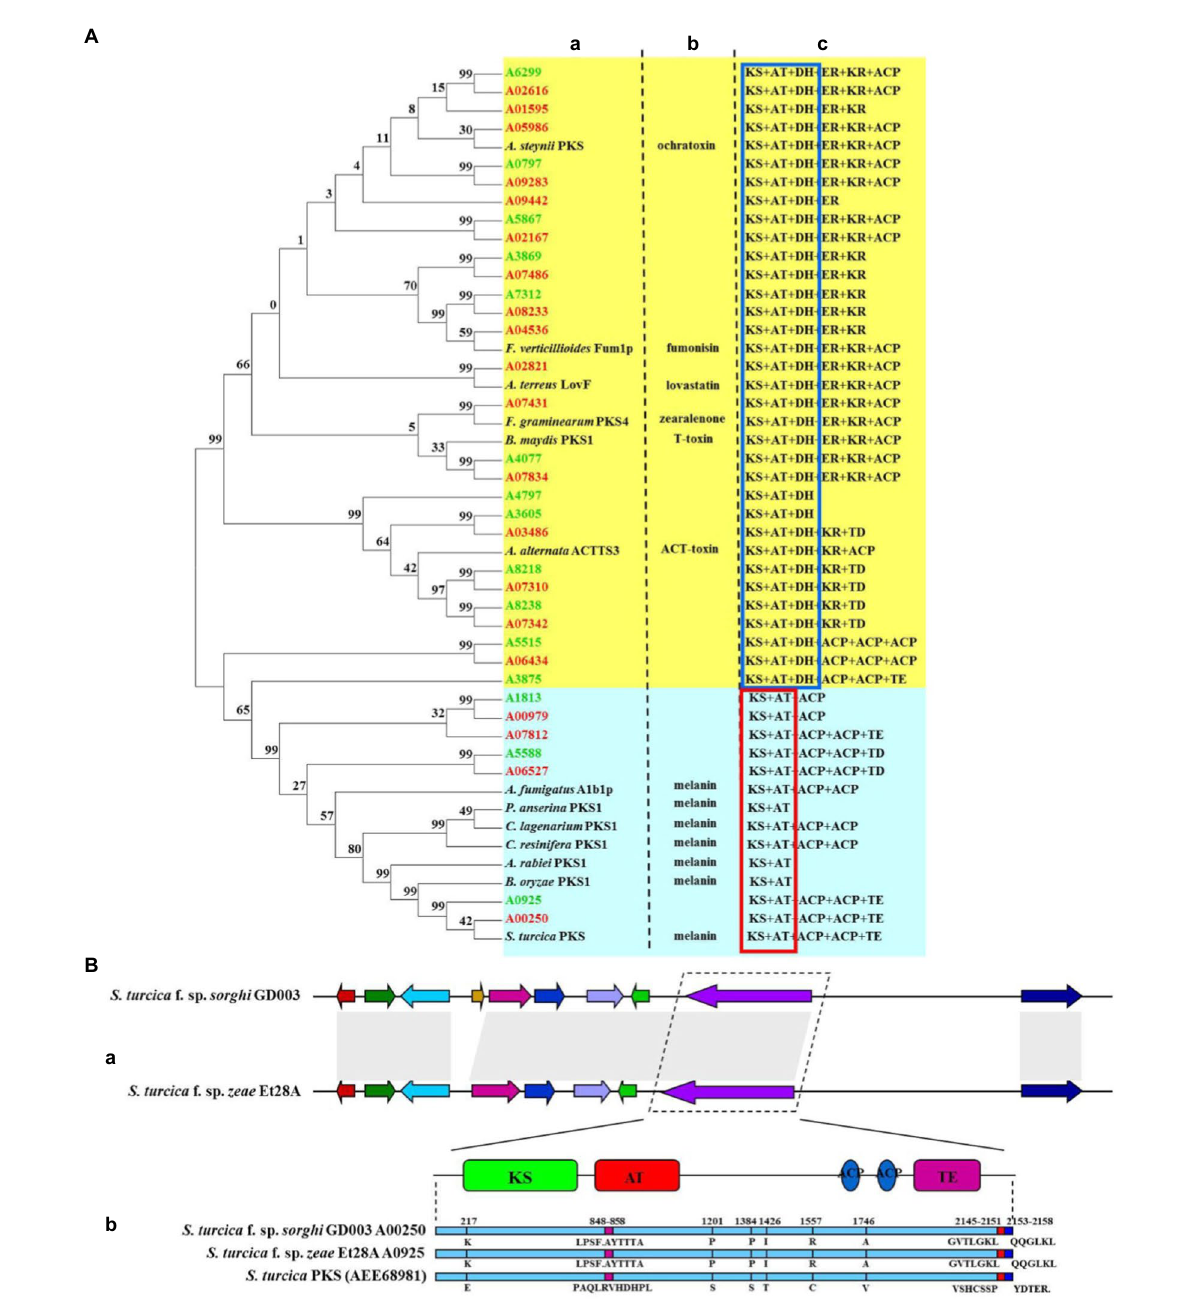
FIGURE 3 Comparative analysis of polyketide synthase (PKS) key genes of two formae speciales of Setosphaeria turcica . (A) Phylogeny and domain comparison of PKSs from Setosphaeria turcica f. sp. sorghi GD003 and S. turcica f. sp. zeae Et28A with that from other known plant pathogenic fungi. (a) Phylogenetic analysis of proteins encoded by PKS genes. (b) PKS-related toxin and melanin from other known phytopathogenic fungi. (c) PKS-associated protein domains. KS, ketoacyl synthase; AT, acyltransferase; DH, dehydratase; ER, enoylreductase; KR, ketoacyl reductase; ACP, acyl carrier protein; TE, thioesterase; and TD, tudor domain. Words marked in green and red indicate gene names for S. turcica f. sp. zeae Et28A and S. turcica f. sp. sorghi GD003, respectively. The red and blue boxes indicate common domains. (B) Comparison of gene clusters and core gene-coding sequences of melanin synthesis in S. turcica f. sp. sorghi GD003 and S. turcica f. sp. zeae Et28A genomes. (a) Melanin synthesis gene clusters of the two formae speciales. (b) Differences in protein sequence of the melanin synthesis core gene from known S. turcica